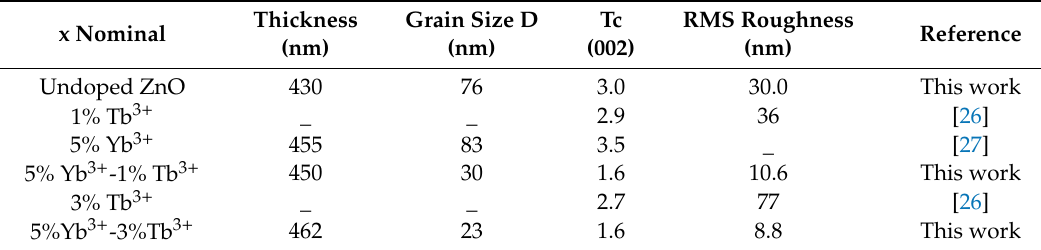
Figure 1. XRD di ff raction spectra of ( a ) undoped ZnO, ( b ) ZnO: 5% Yb 3 + -1% Tb 3 + and ( c ) ZnO: 5% Figure 1. XRD diffraction spectra of ( a ) undoped ZnO, ( b ) ZnO: 5% Yb 3+ -1% Tb 3+ and (c) ZnO: 5% Yb 3+ - Yb 3 + -3% Tb 3 + films. 3% Tb 3+ films. Table 1. Structural parameters of undoped and co-doped ZnO thin Table 1. Structural parameters of undoped and co-doped ZnO thin films.